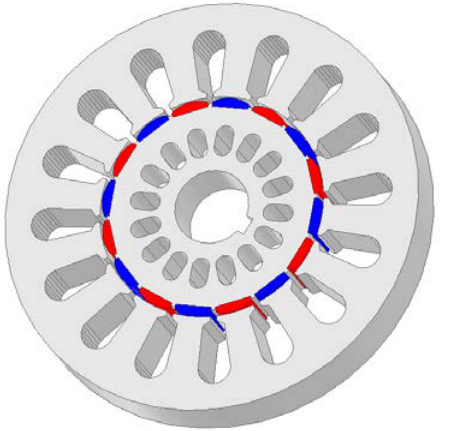
Figure 3. General view of a cogging motor segment with a flat core .